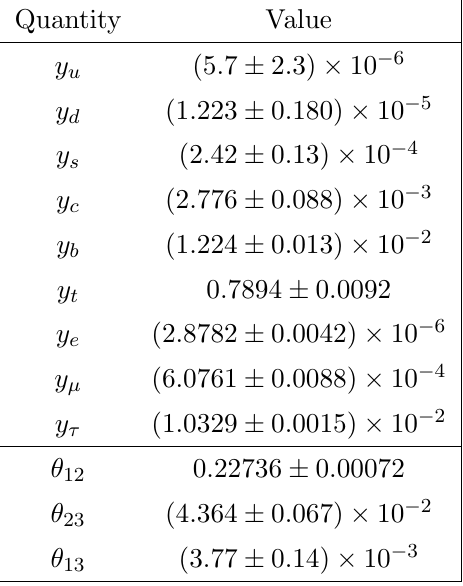
Table 2 . Input values of quark and charged lepton Yukawas and quark mixing angles at 10 TeV taken from ref.